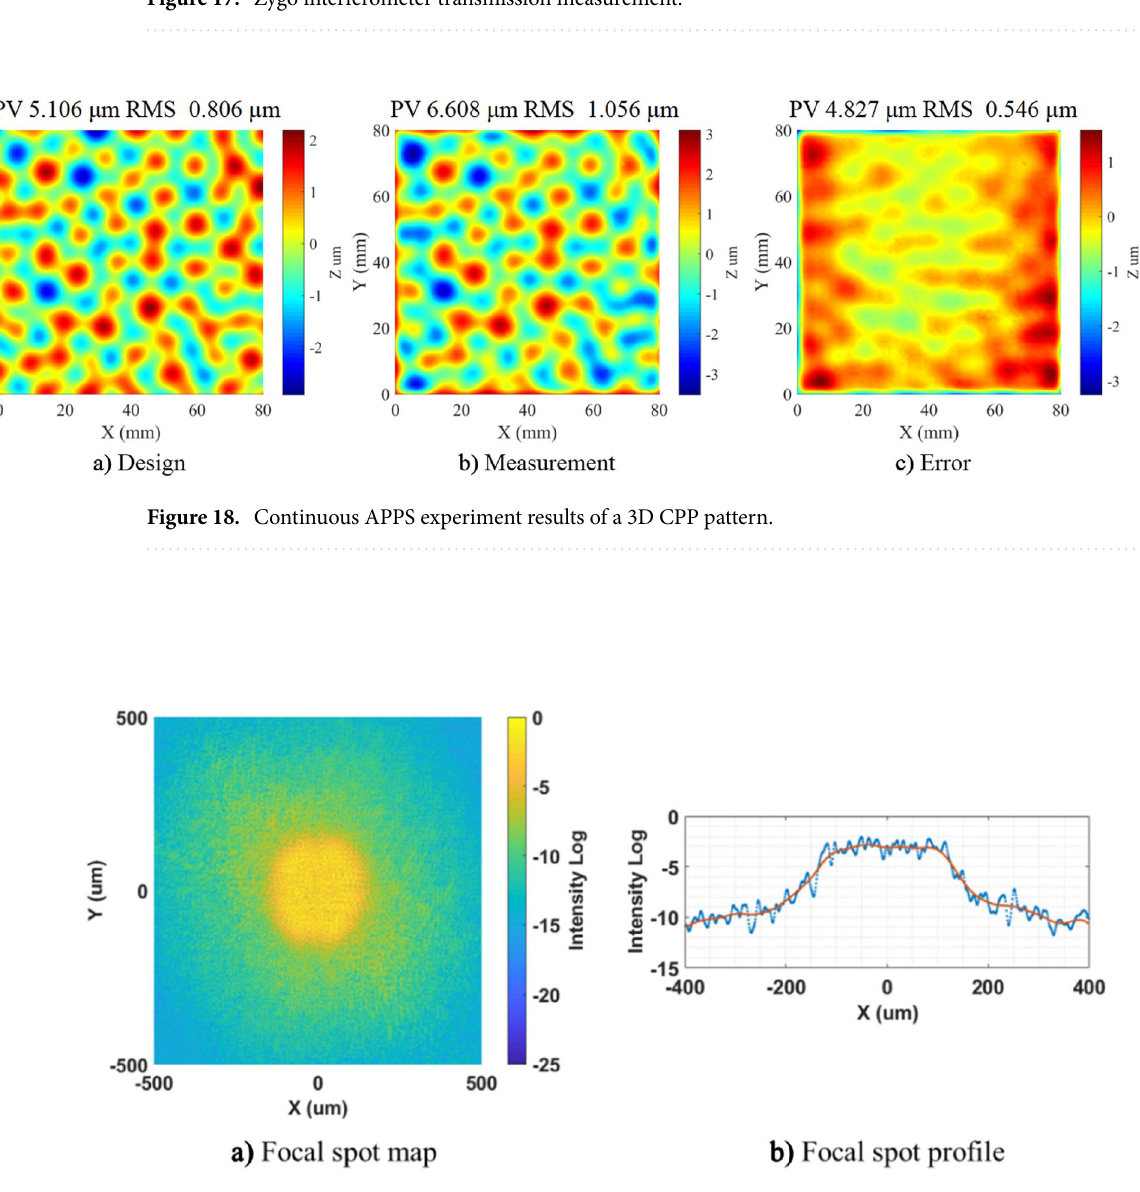
Figure 19. Optical performance evaluation: far field focal